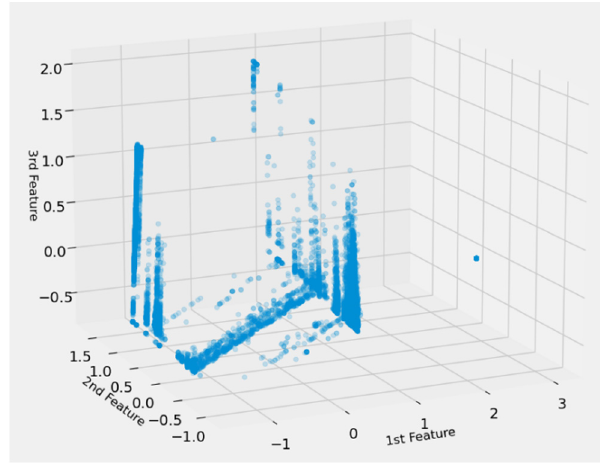
Figure 2. Total captured explained variance by each component.